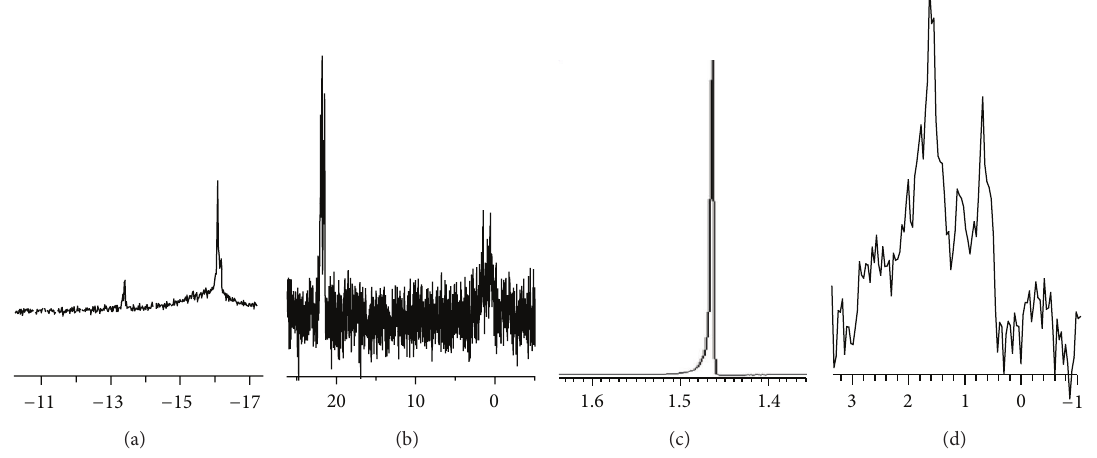
Figure 3: 31 P NMR spectra of (a) PZ, (b) PZ-HEMA-1:3, (c) PZ-HEMA-1:6, and (d) PZ-HEMA-LA.